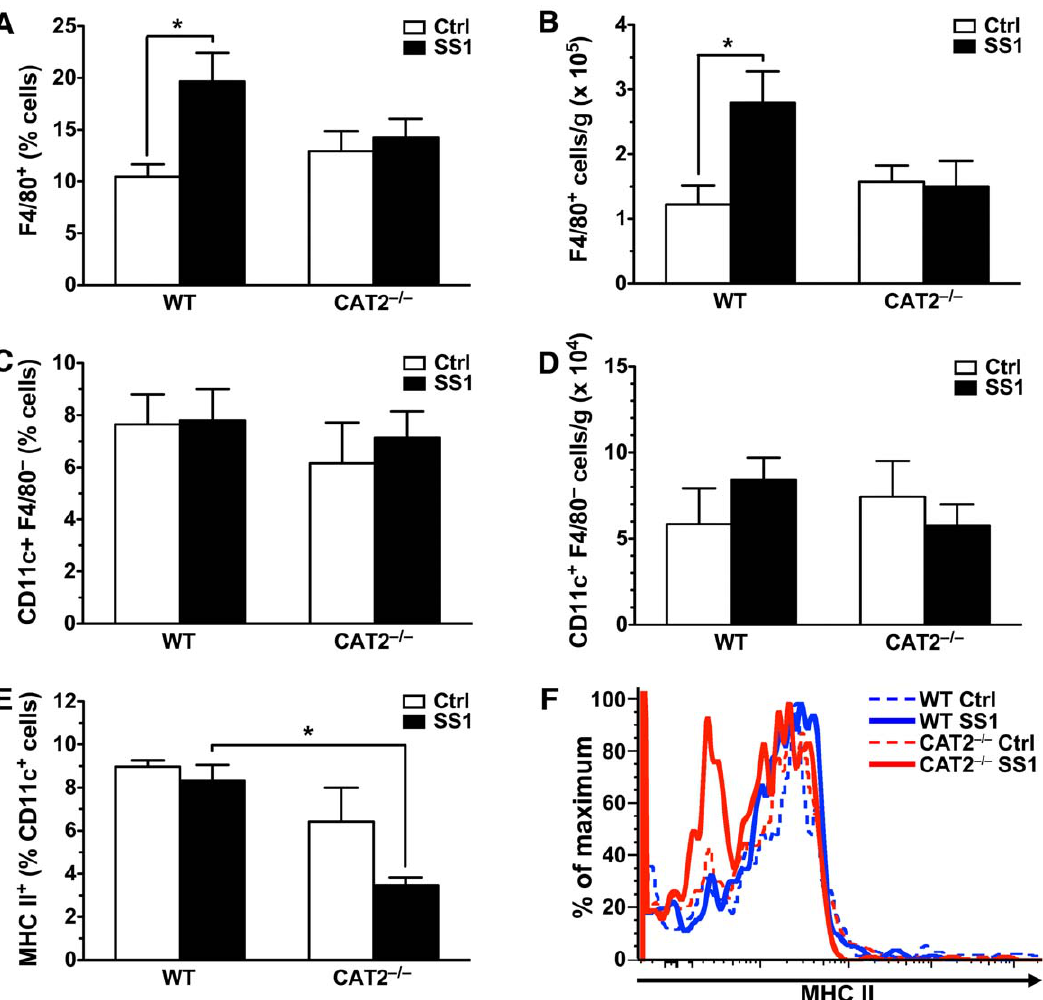
Figure 2. H.pylori -infected CAT2 2 / 2 mice exhibit lower macrophage abundance and less dendritic cell activation. Gastric cells were isolated from mice infected for 48 h with H. pylori SS1 and were analyzed for expression of F4/80, a surface marker of macrophages, and CD11c, a marker of dendritic cells. (A) Percentage of F4/80 + cells per stomach ( n =8 per group). *, p , 0.05 for the comparison indicated. (B) Absolute number of F4/80 + cells/g in these mice. (C) Percentage of CD11c + F4/80 2 cells per stomach ( n =4 per group). (D) Absolute number of CD11c + F4/80 2 cells/g in these mice. (E) CD11c + cells were analyzed for surface expression of MHC II, a marker of activation of dendritic cells ( n =4 per group). *, p , 0.05 for the comparison indicated. (F) Representative histograms of flow cytometric analysis indicating MHC II expression levels within the CD11c +